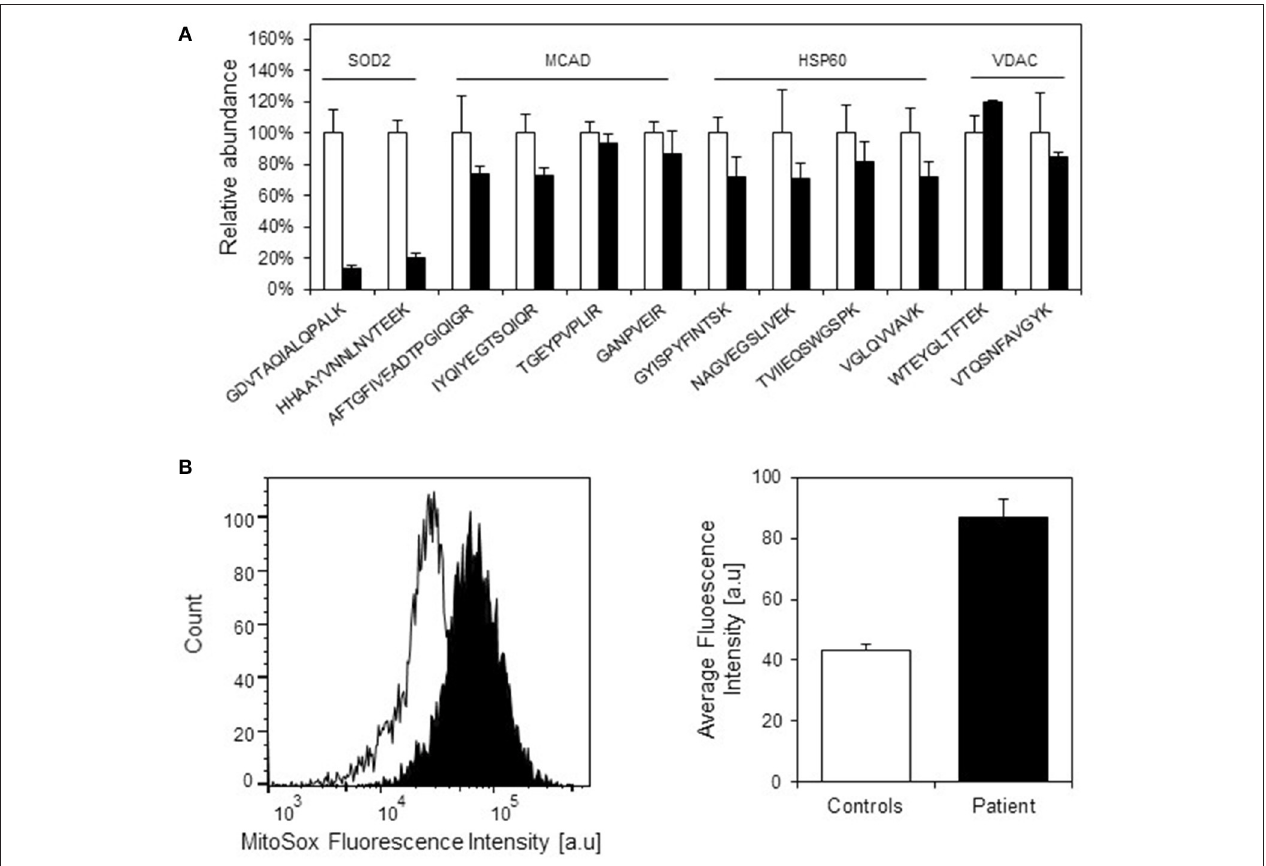
FIGURE 4 | Protein levels of selected mitochondrial proteins in patient and control fibroblasts. (A) Levels of peptides for HSP60, MCAD, VDAC, and SOD2 were measured by SRM-MS. The quantitated amounts of all peptides measured in three different control fibroblast (open bars) were set to 100% and the amounts measured in three parallel grown patient fibroblast cultures (filled bars) were expressed as percent fraction of these. Error bars denote standard deviation of the mean. T-testing showed that the levels of the SOD2 peptides were significantly decreased ( p < 0.05) in patient fibroblasts, while the peptides for MCAD, HSP60, and VDAC were not significantly different in patient compared to control fibroblasts. (B) Mitochondrial superoxide levels. Superoxide levels were determined using the fluorescent superoxide reporter MitoSOX. The left graph shows the histogram from one analysis; open peak: control, closed peak: patient. The right graph shows average mean fluorescence intensities measured from three independent cultivations and analyses of control fibroblasts and parallel cultivations of the patient fibroblast. Error bars represent SEM for the three respective replicates.